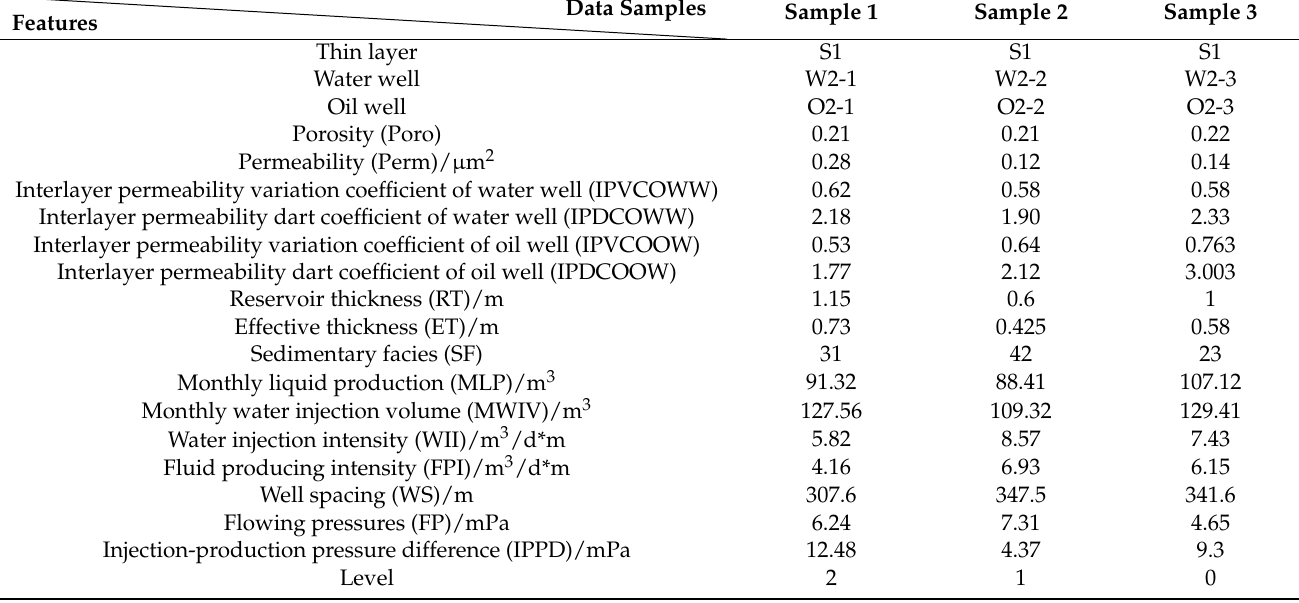
Table 1. Sample data set.